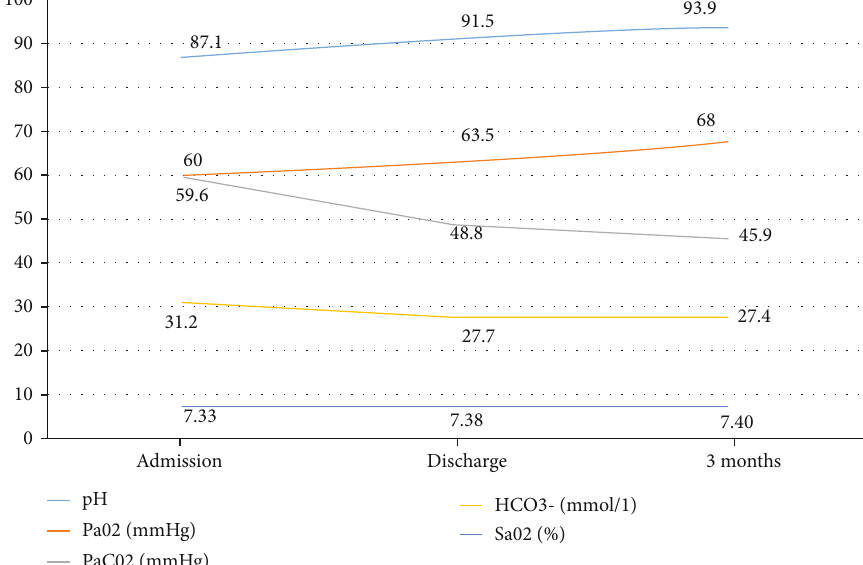
: arterial partial pressure of oxygen; HCO3: concentration of 2